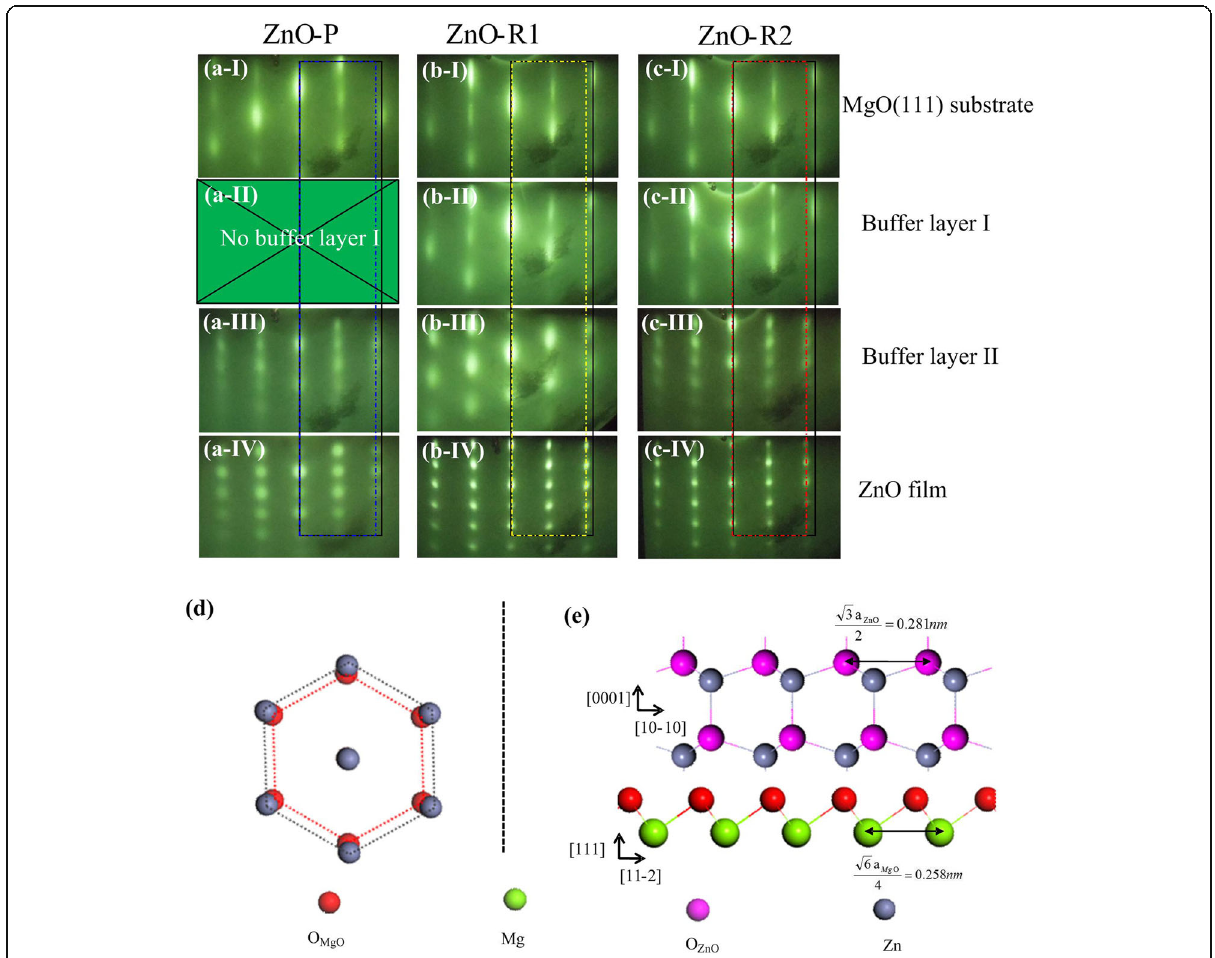
Fig. 3 RHEED results and structure models. a – c RHEED patterns of the surface structures for the substrate and the epilayers recorded at different stages (I, II, III, IV). d , e Schematic models of the epitaxial relationship between the MgO(111) substrate and ZnO(0001)